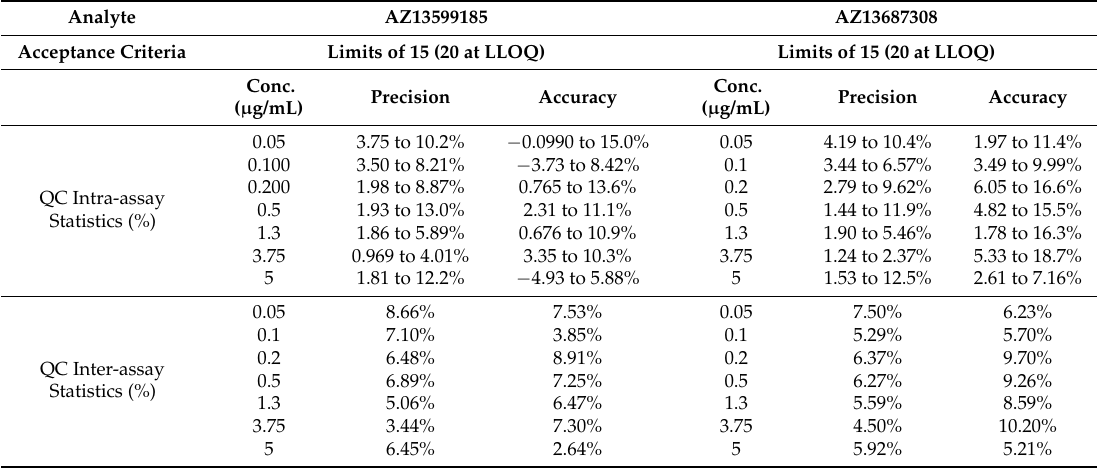
Table 7. Unconjugated AZ13599185 and AZ13687308 precision and